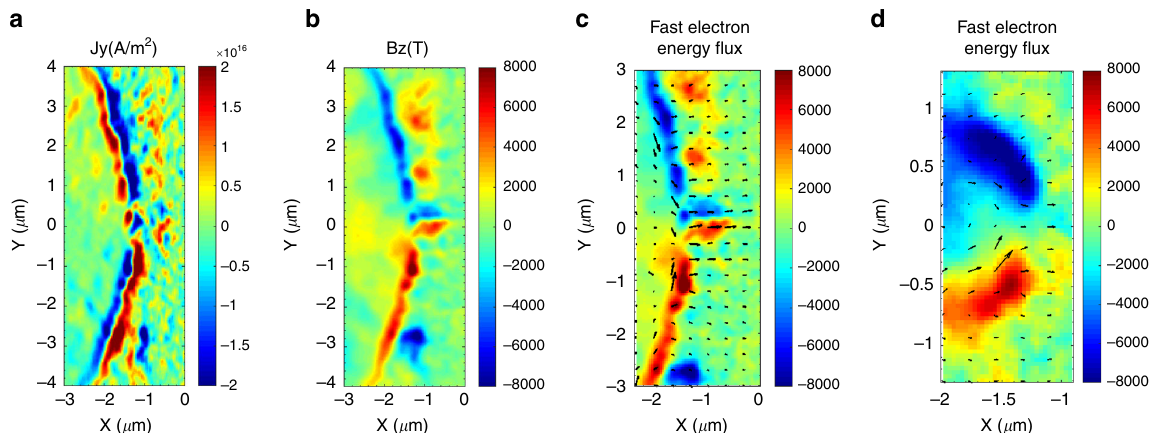
Fig. 4 Current density and magnetic fi eld maps. Current density and magnetic fi eld maps restricted to a single wavelet interaction for P = 11 μ m and P = 2.9 μ m and related fast electron energy fl ux. a Cycle-averaged y-component of the electron current density and b surface magnetic fi eld structure at peak laser irradiation for P = 11 μ m. The fast electron current fl ows predominantly along the surface towards the center of the modulation/deformation and we can observe the corresponding return current fl owing antiparallel to the fast electron current. A strong B- fi eld structure develops between fast electron and return current effectively preventing the fast electrons from penetrating in the overdense plasma until they reach the modulation valley. Cycle-averaged fast electron energy fl ux (block arrows) superposed to the magnetic fi eld snapshot at peak laser irradiation for c P = 11 μ m and d P = 2.9 μ m. In both cases we observe that a large fraction of the fast electron energy fl ows along the surface con fi ned by the balanced action of surface B- fi eld and charge separation electric fi eld and is fi nally injected in the overdense plasma at the modulation valley where the B- fi eld rapidly reverses sign. This mechanism is responsible for the enhanced laser-to electron energy conversion ef fi ciency even for large values of α